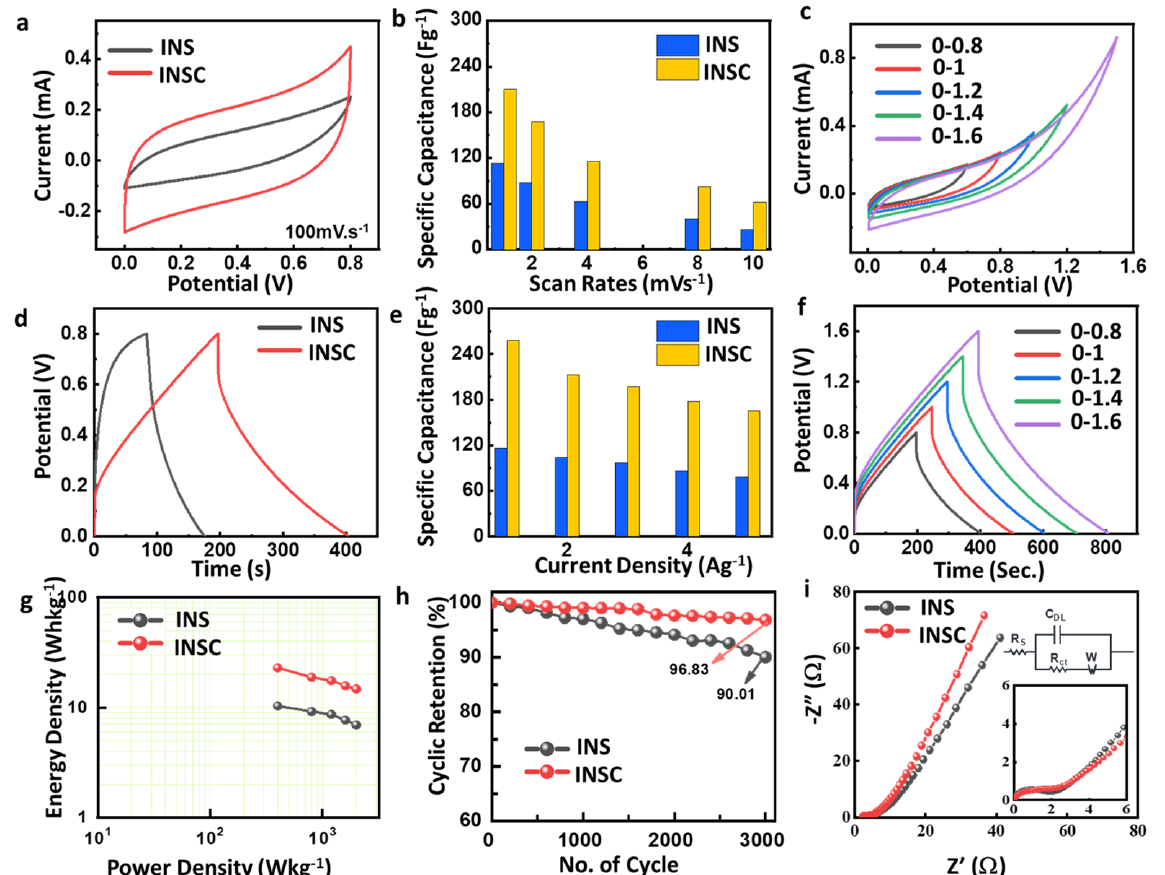
Figure 2. ( a ) Comparative CV curves at a scan rate of 100 mVs − 1 ; ( b ) extracted specific capacity values at various scan rates; ( c ) CV curve at the various potential windows at a scan rate of 100 mVs − 1 ; ( d ) comparative GCD curves; ( e ) extracted specific capacity values at various current densities; ( f ) GCD curve at the various potential windows; ( g ) Ragone plot; ( h ) cyclic stability spectra; and ( i ) Nyquist plot of sample INS and INSC.